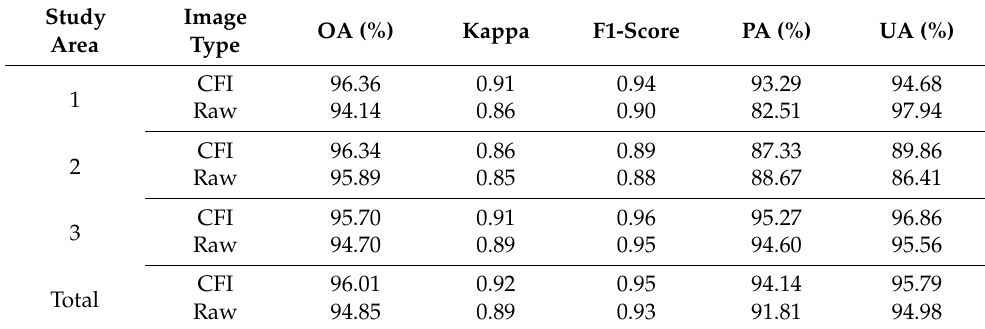
Table 4. Classification accuracy based on CFI images and Sentinel-2 raw images using the